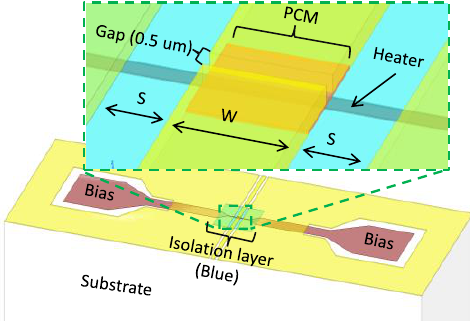
Figure 5. PCM SPST-simulated HFSS 3D model with features.